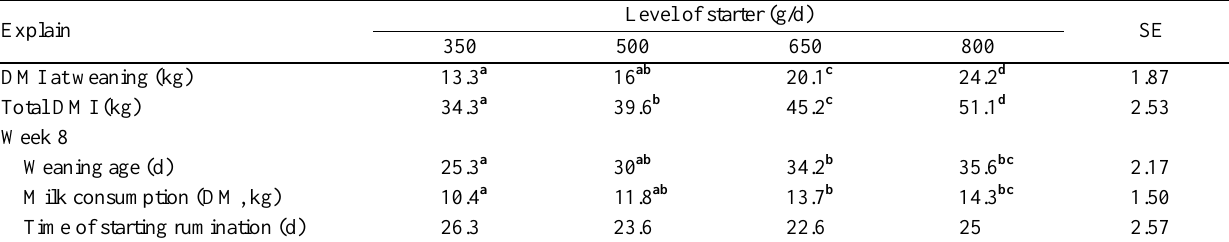
Table 3. Effects of levels of starter on total DMI (milk and starter), days to weaning and time of starting rumination Explain